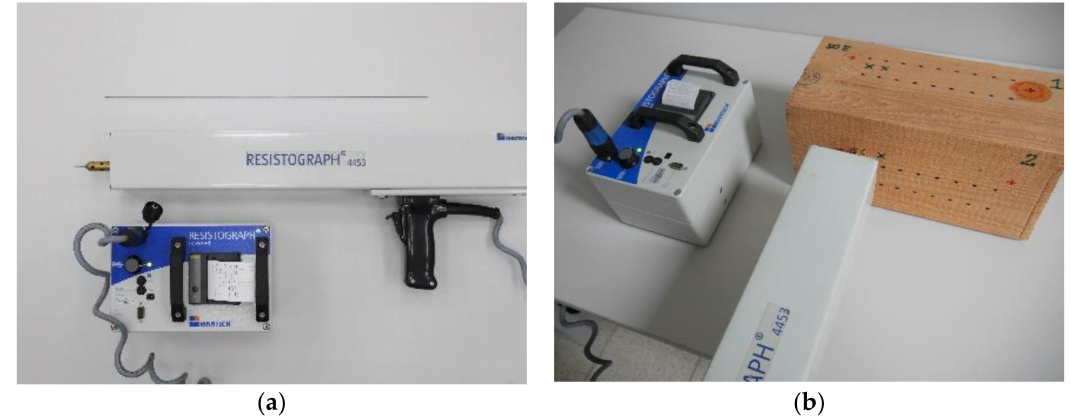
Figure 7. The device used for SDT studies. ( a ) Rinntech resistograph for resistance drilling tests; ( b ) Device conducting a